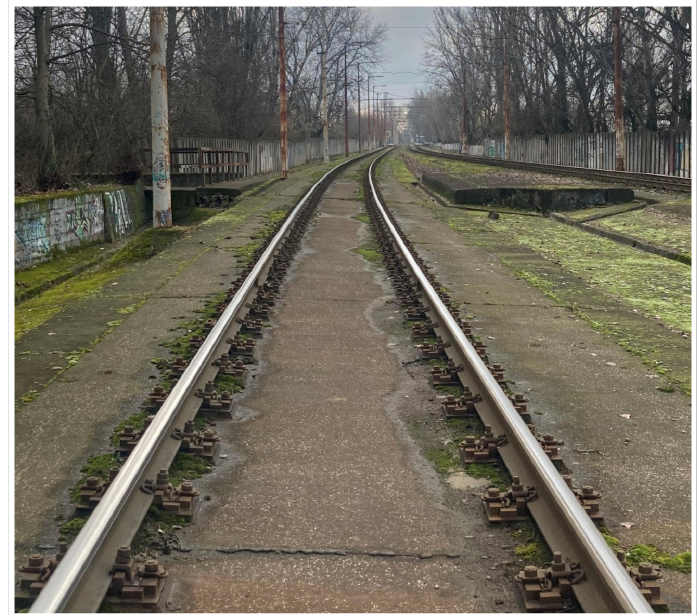
Figure 5. Photo of Section #5 (own